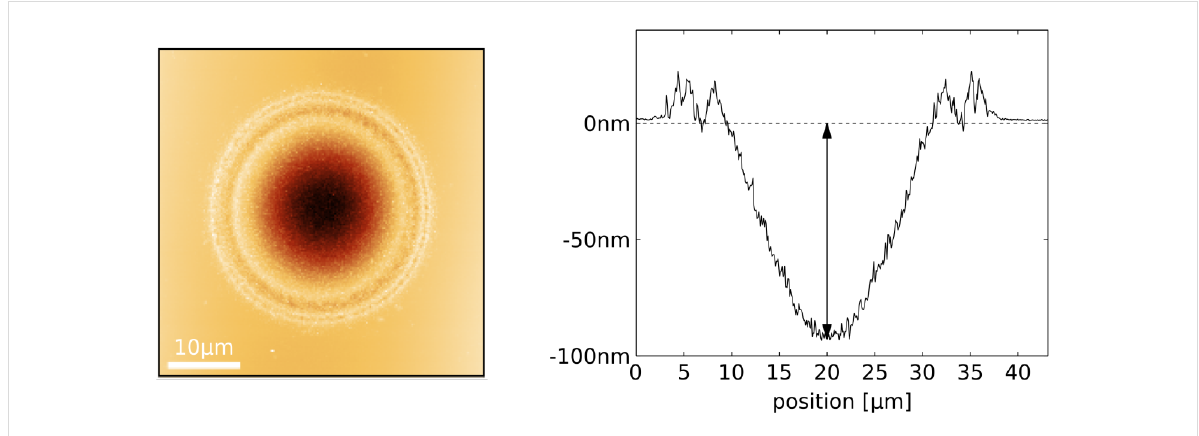
Figure 9: AFM image and height profile of an ablation hole generated by far-field ablation of bare Si (same wafer as in Figure 7). Note that the beam profile in this case is again described by an Airy distribution, comparable with the irradiation of the nanostructures.